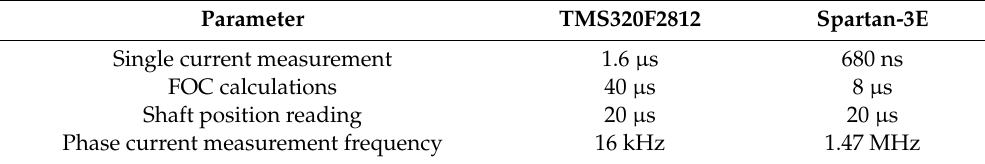
Table 4. The selected performance of the TMS320F2812 and the